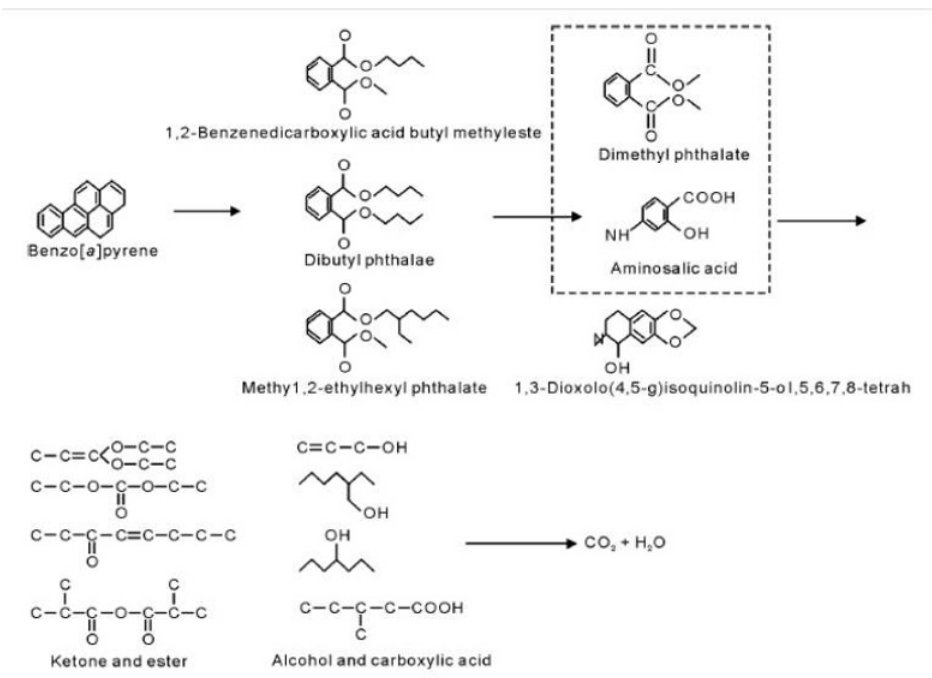
(µL; a) and O (µL; b); degradation of BaP. 2 2